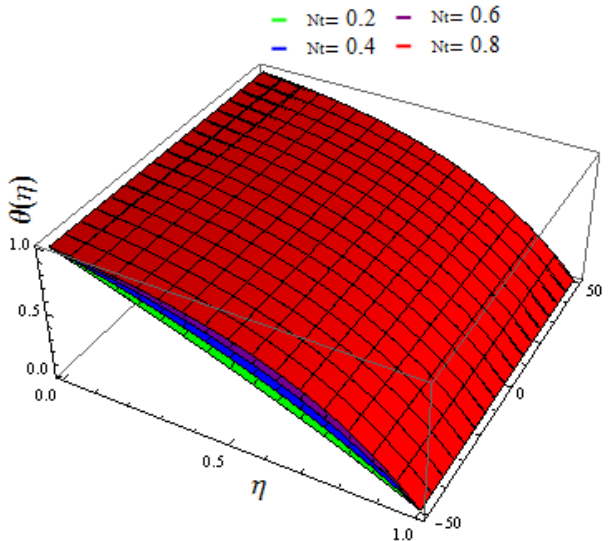
Figure 10. Impact of Nt on θ ( η ) .